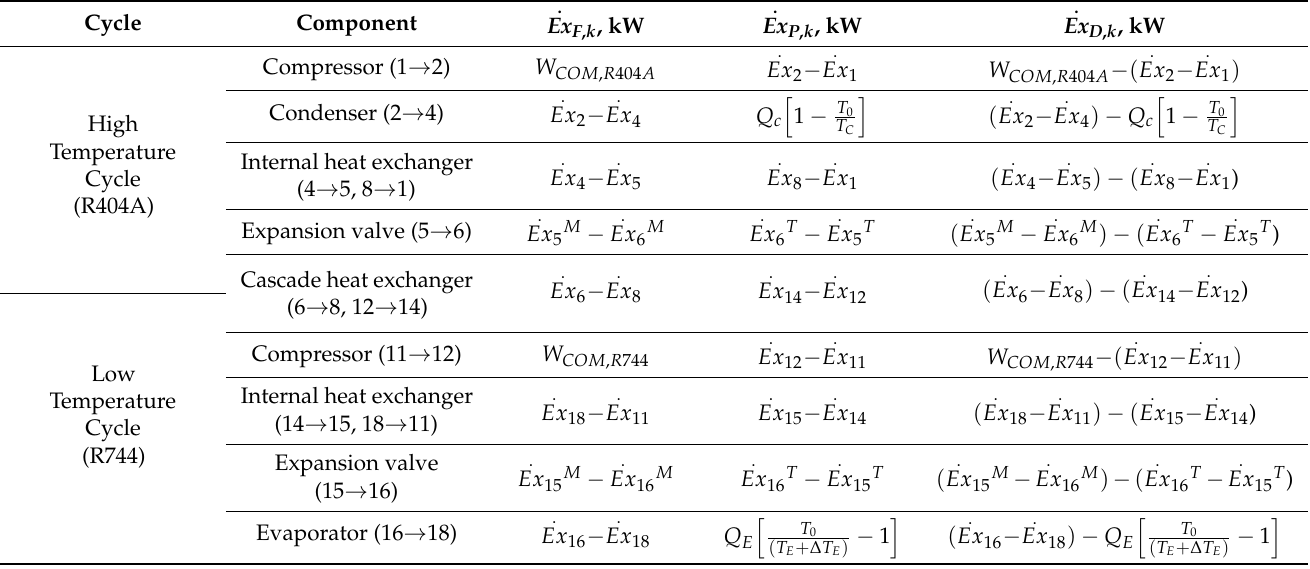
Table 4. Entropy and exergy balance equation for each component of the CRS using R744 and R404A [15,22,23].